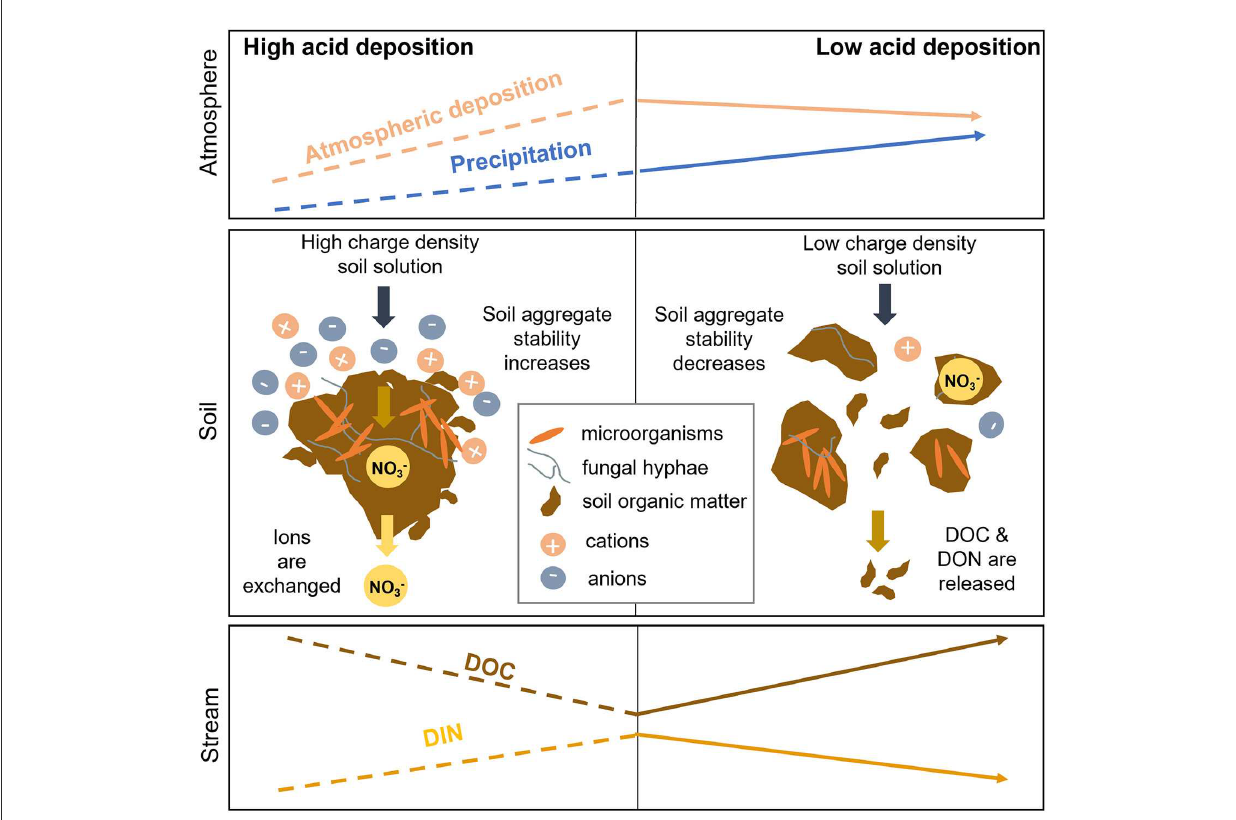
FIGURE5 Conceptual model of the connection between atmospheric inputs (top panel) , soil processes (middle panel) and stream water response (bottom panel) during times of high acid deposition (left panel) and low acid deposition (right panel) . Data on atmospheric inputs and stream response during the onset of acid deposition are sparse and thus indicated by dashed lines, while decrease in acid deposition is well documented and trends are indicated with solid lines. During high acid deposition, high charge density of soil solution stabilizes soil aggregates and colloidal associations, but high ion concentration leads to ion exchange [exemplified for nitrate (NO − 3 )]. In contrast, low acid deposition leads to lower charge density of soil solution, causing aggregate destabilization and ensuing release of dissolved and colloidal dissolved organic matter and dissolved organic nitrogen [dissolved organic carbon (DOC) and dissolved organic nitrogen (DON)] from soil organic matter. DIN, dissolved inorganic